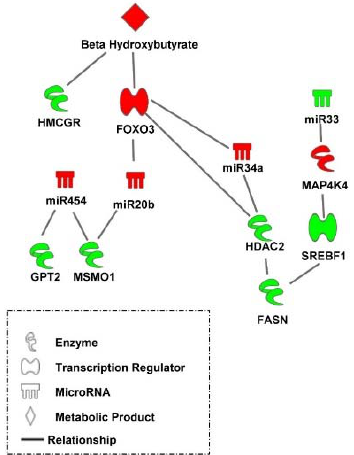
Figure 8. A transcriptional and post-transcriptional regulatory system mediating the hepatic metabolic switch in chickens. A delayed feeding regime to retard the metabolic switch in broilers uncovered a complex transcriptional and post-transcriptional hepatic regulatory system which is triggered by nutritional / physiological cues to facilitate the metabolic transition in peri-hatch chickens. Red molecules have higher levels in broiler chicks with delayed access to feed for 48 h post-hatching compared to their fed from hatch counterparts and green molecules had lower levels in delayed fed chicks. Pathway was created using Ingenuity Pathway